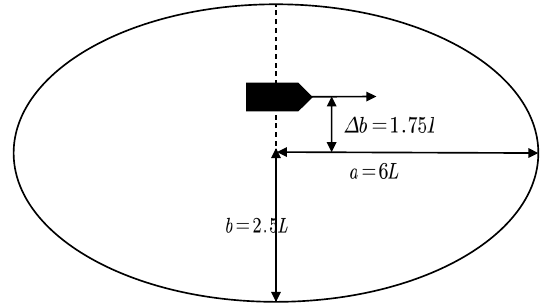
Figure 2. Ship domain of Coldwell.